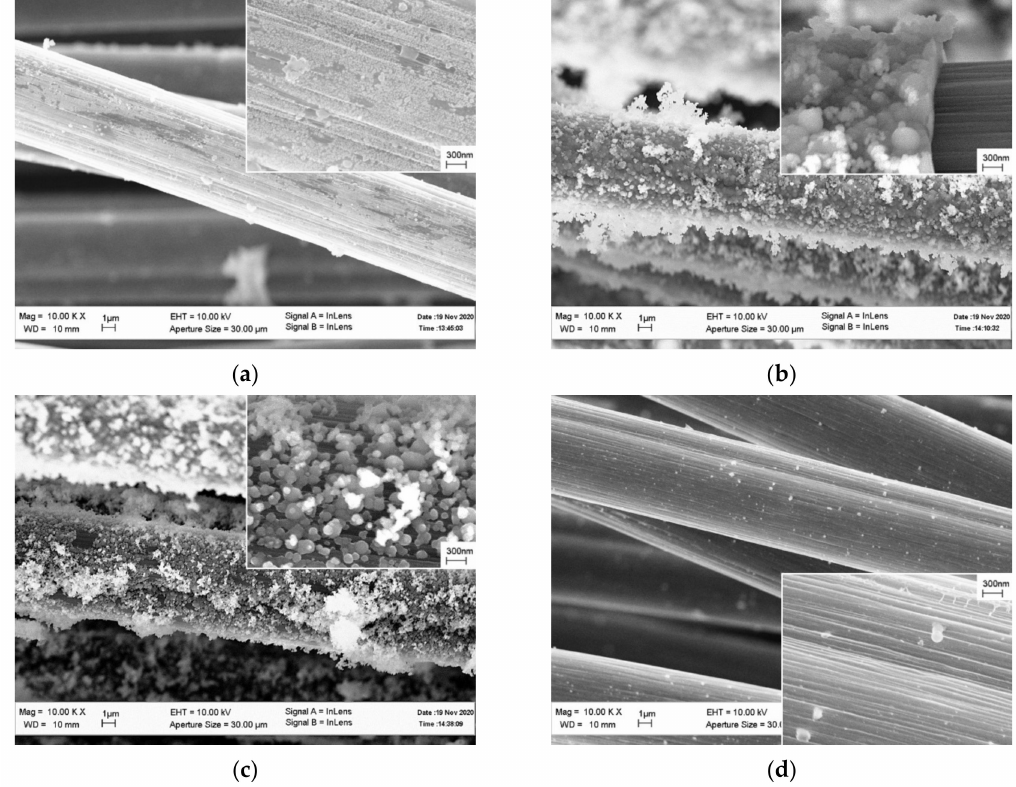
Figure 5. Surface of the coated carbon fiber formed in the reaction medium with different pH values: ( a ) pH = 4.6, ( b ) pH = 2.2, ( c ) pH = 1.9, ( d ) pH =